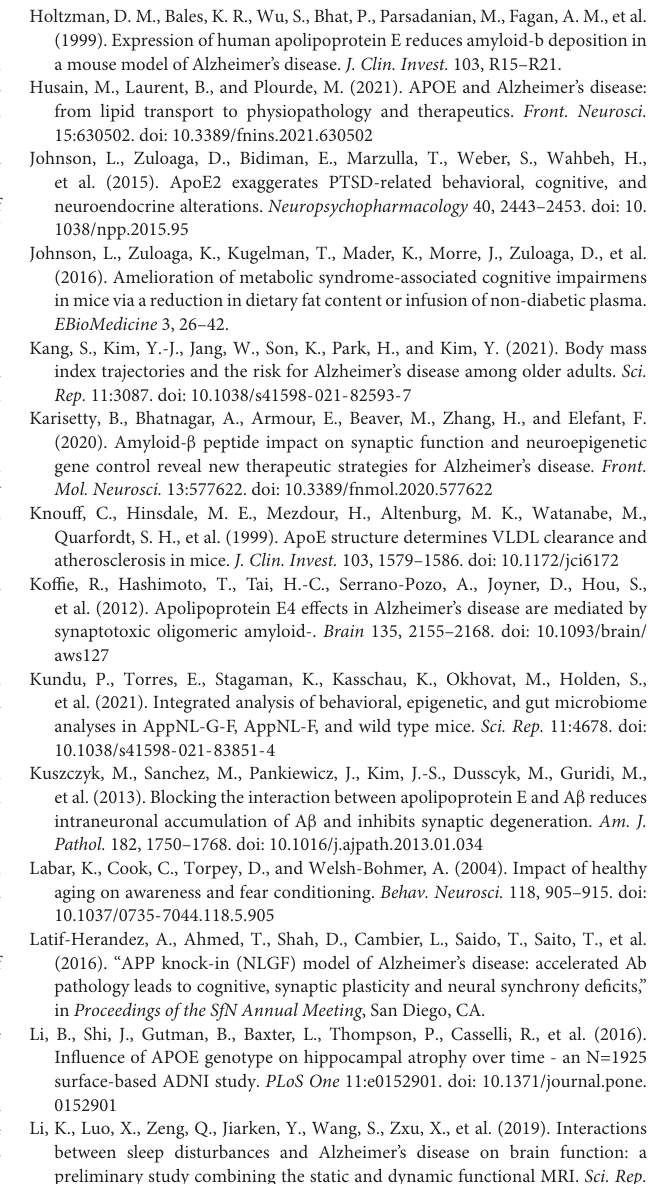
trend toward higher activity levels in NL-G-F than WT males. (D) Activity levels of NL-G-F, NL-F, and WT females during the dark period. (E) Activity levels of NL-G-F, NL-F, and WT males during the light period. (F) There was an effect of APP on activity levels of females during the light period. There was a trend of NL-F and NL-G-F females being more active during the light period than WT females. (G) There was an effect of APP on fall scores of males in the wire hang test. NL-G-F males had lower fall scores than NL-F and WT males. ∗ p < 0.05. (H) There was an effect of APP on fall scores of females in the wire hang test. NL-G-F females had lower fall scores than NL-F and WT females. (I) There was an effect of APP on reach scores of males in the wire hang test. NL-G-F males had lower reach scores than NL-F males. ˆ p < 0.05. (J) Reach scores of NL-G-F, NL-F, and WT females. (K) Activity levels of NL-G-F, NL-F, and WT males in the open field. (L) Activity levels of NL-G-F, NL-F, and WT females in the open field.